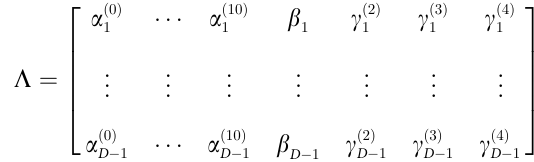
S2 Fig. Bias visualized for mock community data, proportions. To visualize the scale of